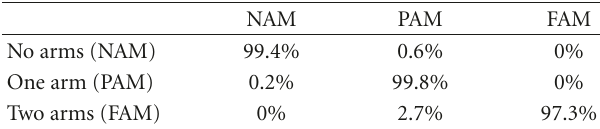
Table 2: Confusion matrix for classification rates of the three human motions collected at 0 ◦ incidence angle.